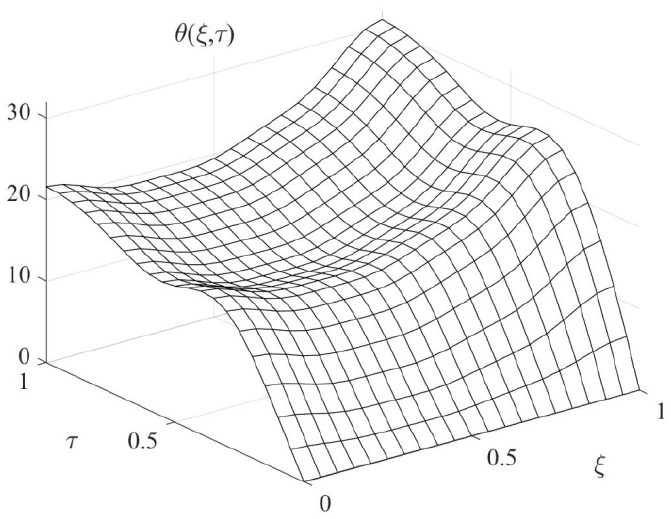
Figure 3. Temperature distribution graph is case of time-variant α . This method is applicable for the heat conduction in case of two or three spatial vari- ables, with mixed type boundary conditions and a time-dependent heat transfer